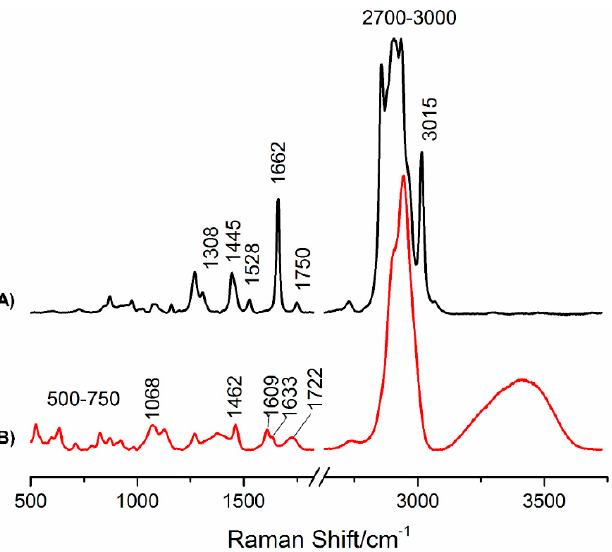
Figure 3. FTIR-ATR spectrum of the BSR C. album berry extract.